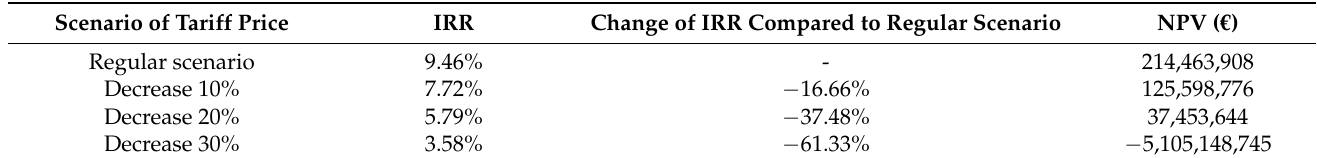
Table 4. Results of tariff price sensitivity analysis.